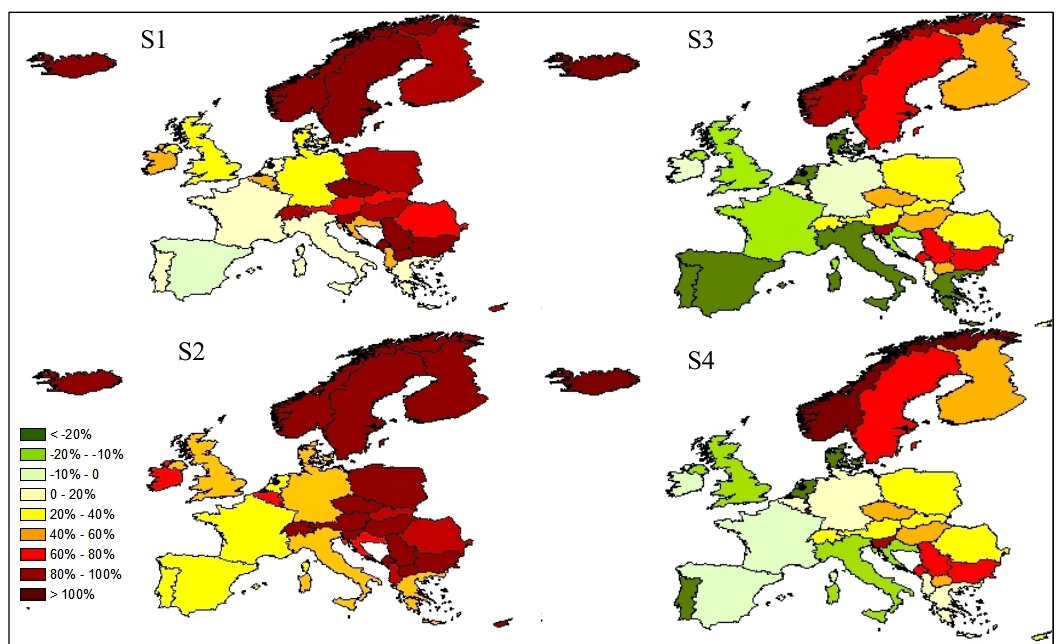
Figure 3. Percentage change of the blue WF of production relative to 2000.